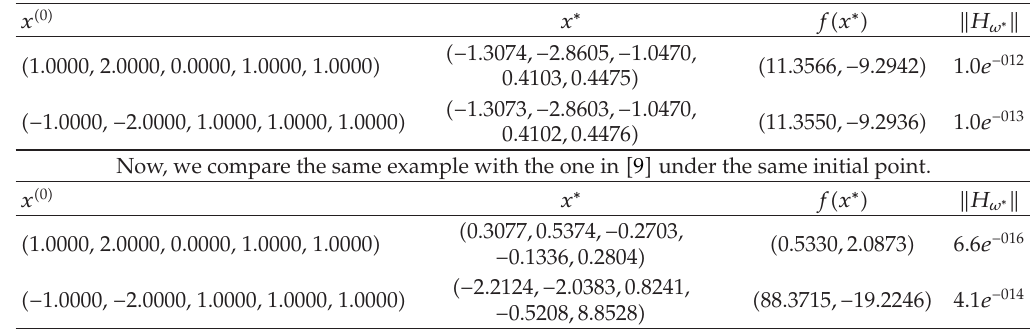
Table 1: Results for Example 4.2.